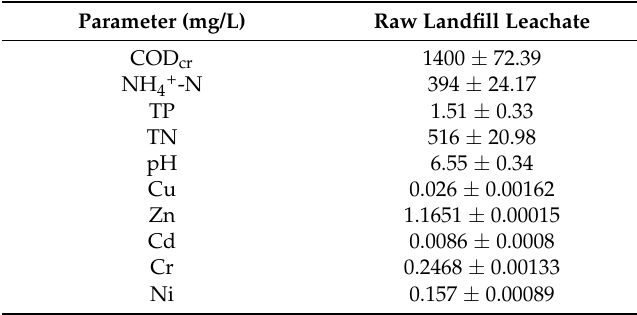
Table 2. Details of the competition of the raw landfill